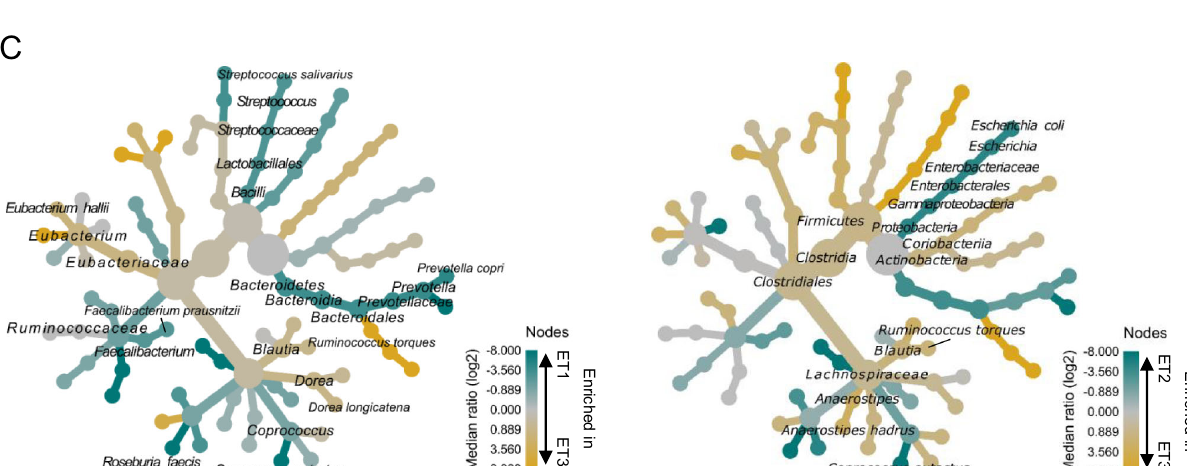
Fig. 4 Association between soil-transmitted helminths cure and pre-treatment enterotype (ET) by treatment arm and species-level characteristics of each enterotype. A Association between treatment outcome of Trichuris trichiura and ET at baseline. B Association measured between treatment outcome of hookworm and ET before treatment. The cure rate is de fi ned as the presence or absence of eggs in stool between day 14 and day 28 after treatment ( = average eggs per gram of stool in samples collected between days 14 and 28 after treatment). C Species-level differences between compositional clusters ( = enterotypes). Fisher ’ s exact tests were two-sided and the 95% con fi dence interval of the odds ratios is shown in the bracket. Labels on the pie charts represent the number of patients in each group. n number of patients, OR odds